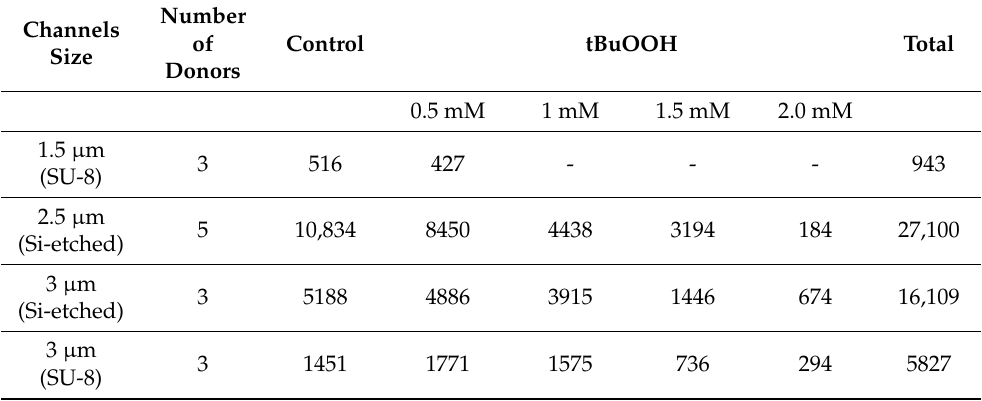
Table 1. The number of analyzed cells in each